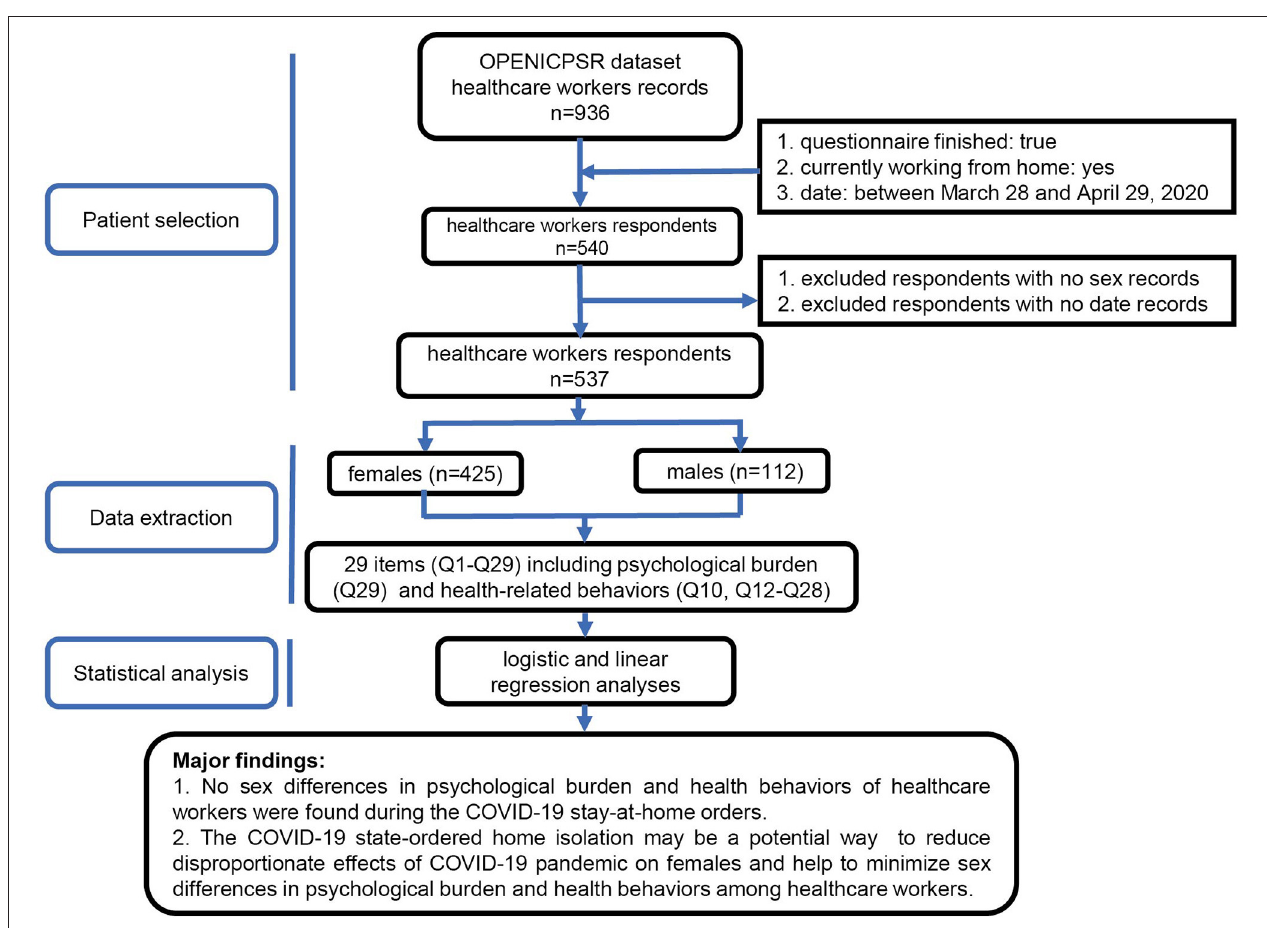
FIGURE 1 | Workflow and major findings of this study. OPENICPSR, open Interuniversity Consortium for Political and Social Research; COVID-19, novel coronavirus disease